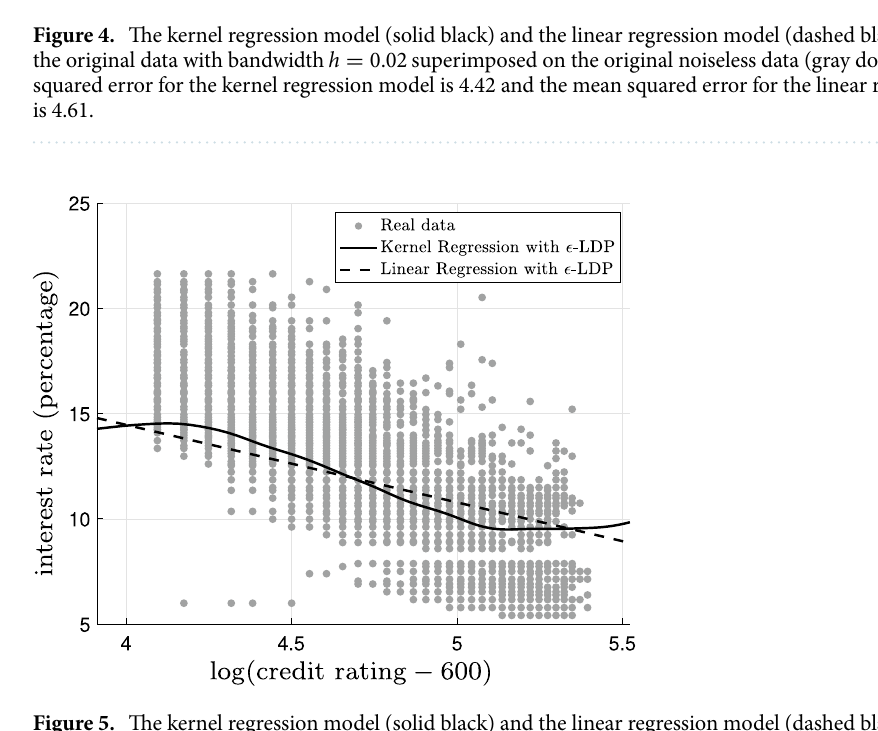
Figure 5. The kernel regression model (solid black) and the linear regression model (dashed black) based on 5 and bandwidth h 0.20 superimposed on the original noiseless the ǫ -locally differential private data with ǫ = = data (gray dots). The mean squared error for the kernel regression model is 5.70 and the mean squared error for the linear regression model is